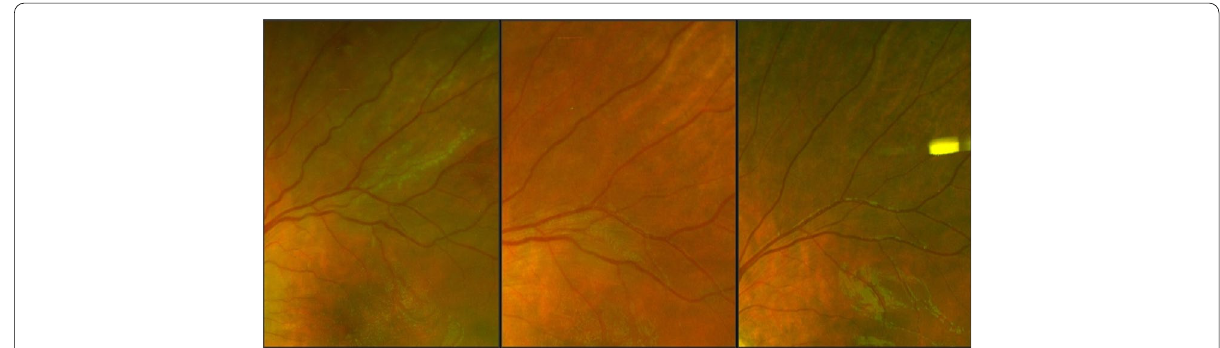
Fig. 4 A , B and C Pseudo color wide-field fundus photographs of the left eye taken (4 a ) one month after presentation showing resolving serous detachment, vascular tortuosity and macular edema, and 4 b six weeks after presentation. 4 c taken at 4 months demonstrates return to relatively normal appearing vasculature with resolving of previously noted vascular